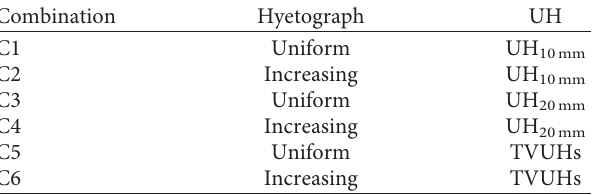
Table 8: Combination of UHs and hyetographs.